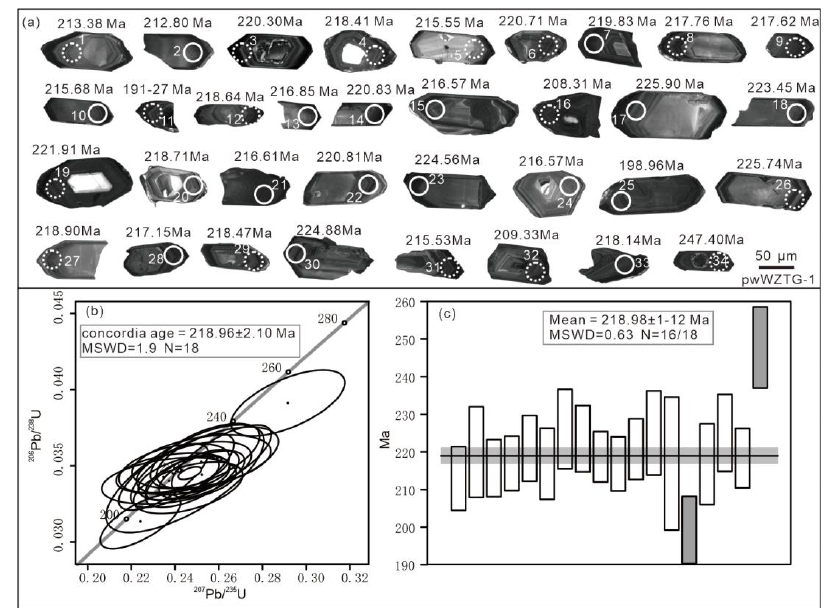
Figure 4. Cathodoluminescence images and ages of zircons in the monzogranite from the Wuzhutang granite in the Xuebaoding mining area, Sichuan Province, China. ( a ) Characteristics and dating results of zircon. ( b ) Concord age of zircon. ( c ) Weighted mean age of zircon.